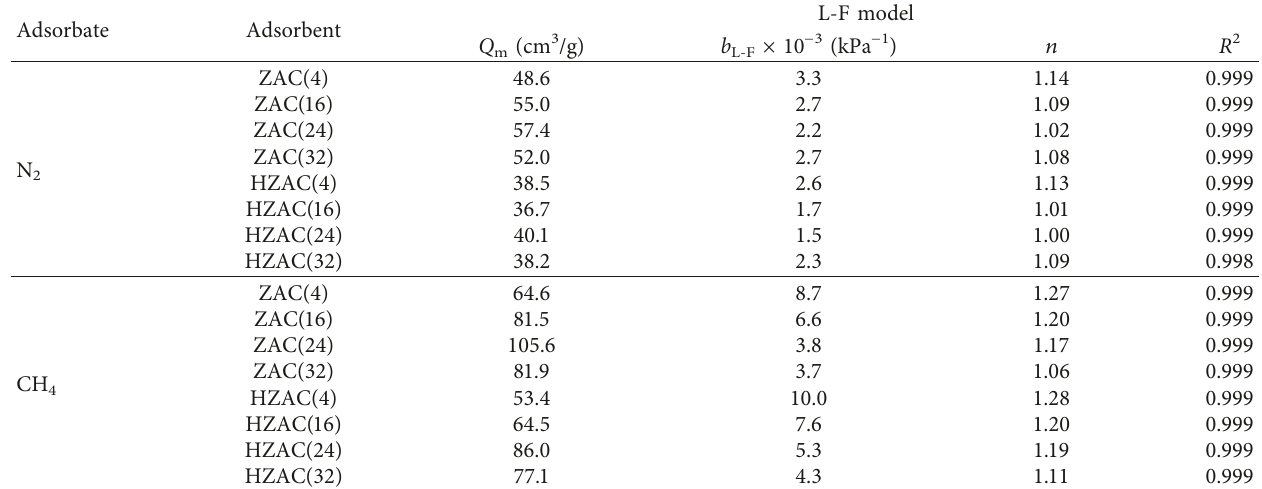
Table 2: L-F fitting parameters of CH 4 and N 2 isotherms on ZAC( t a ) and HZAC( t a